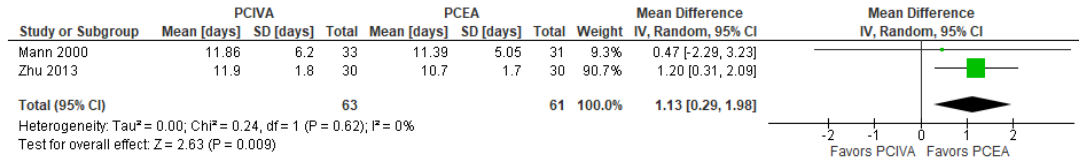
Figure 6. Length of hospital stay [10,19].